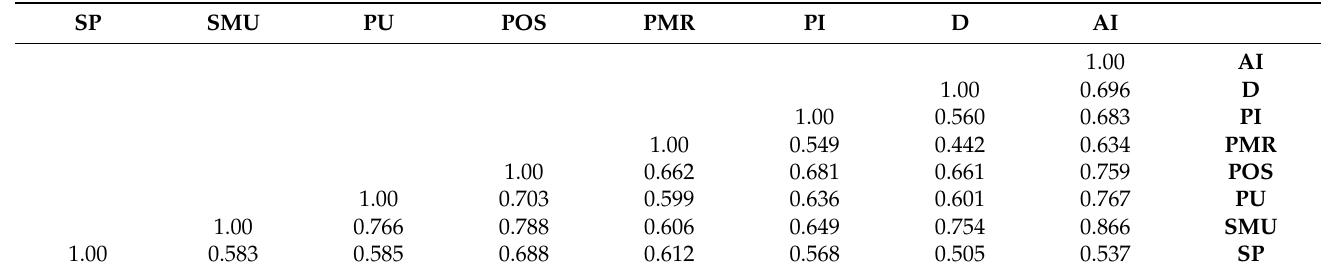
Table 3. Fornell and Larcker criterion.